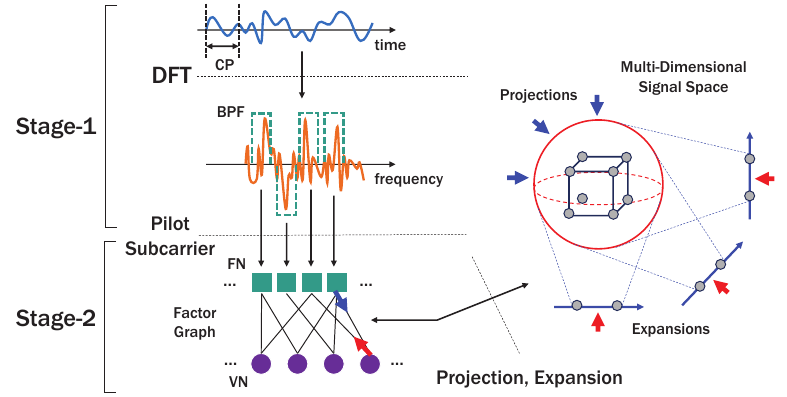
Figure 7. Brief overview of MSC-AmBC detection at the